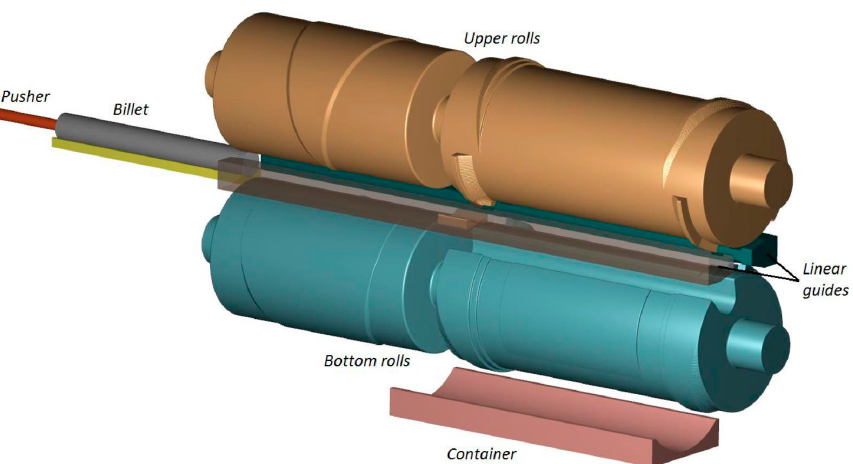
Figure 7. Model of two-stage CWR for producing rail axles by rolls with 1200 mm nominal diameter [9] (Reprinted from ref. [9]).